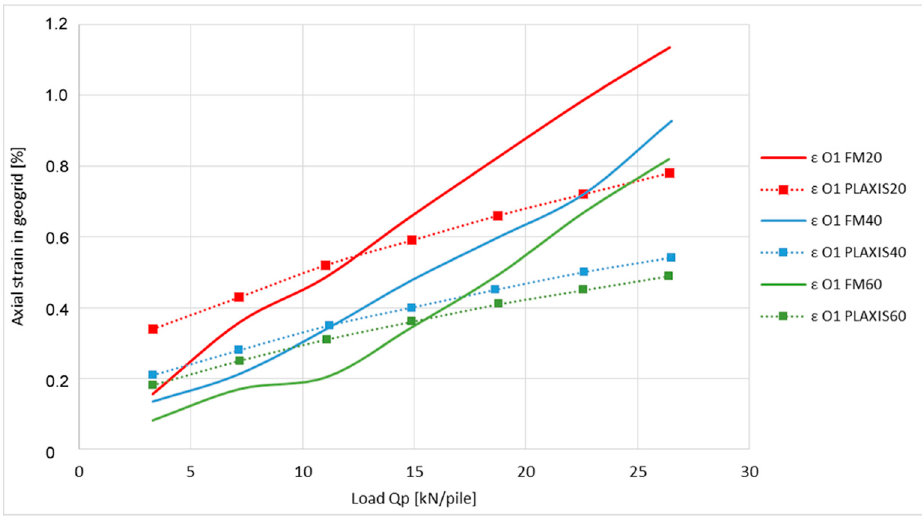
Figure 13. Comparison of axial strain of geogrid at place O1. Graphs show the outputs of three different measurements from the physical model as well as outputs of the three numerical simulations. In both of the cases, outputs are from measurements which are related to model tests where the strength of the geogrid used was 20, 40, and 60 kN · m − 1 .